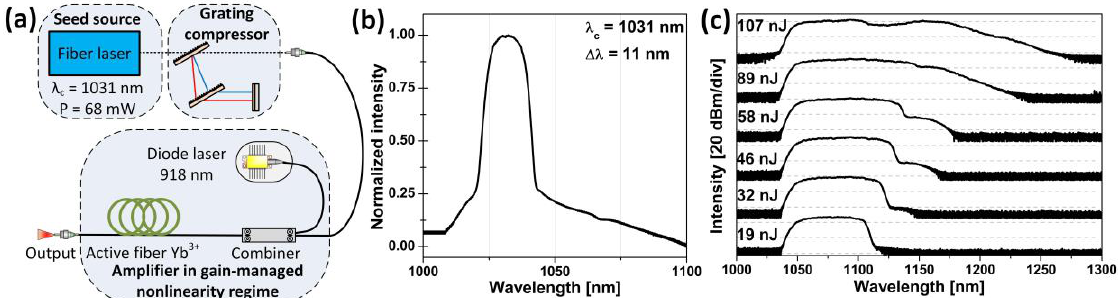
Fig. 1. Experimental setup of the GMN amplifier (a). Optical spectrum of the seed laser (b). Optical spectra of seed laser amplified in GMN regime